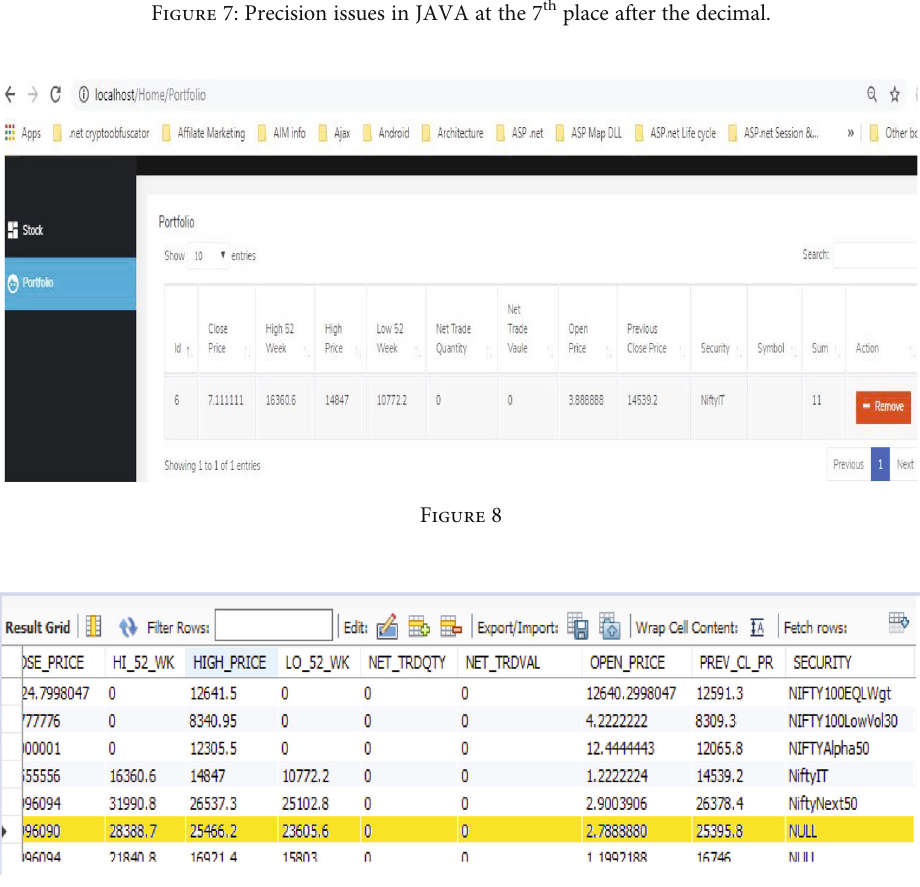
Figure 9: Adding null to stock